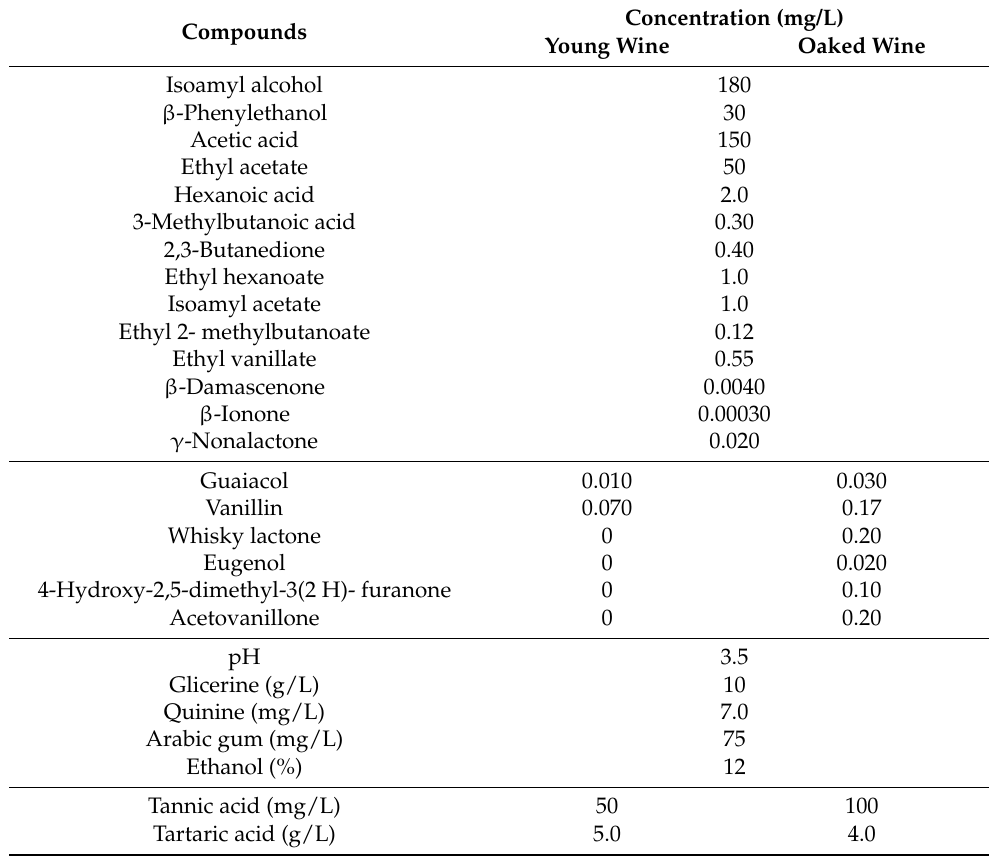
Table 1. Wine models composition.